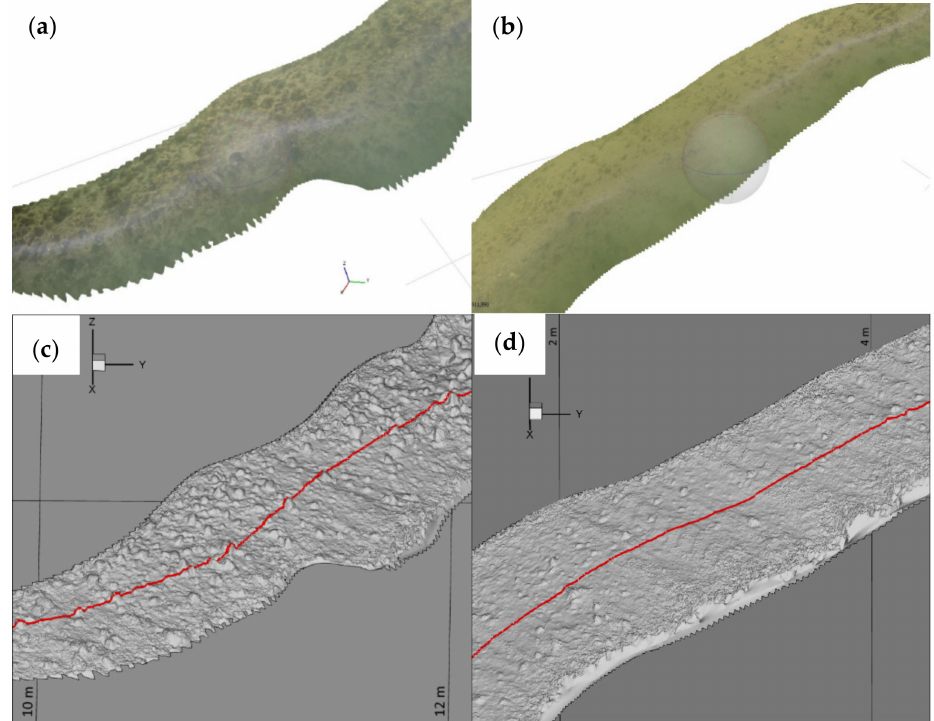
Figure 14. The coarser part of the section (between 10 and 12 m along the section) on the left ( a , c ) and a smoother part on the right (between 2 and 4 m along the section) ( b , d ). The red line is the polyline along which the total profile was retrieved. The pictures on top ( a , b ) are the stitched images from the recording, while the pictures on the bottom ( c , d ) are the corresponding three-dimensional (3D) models of the given